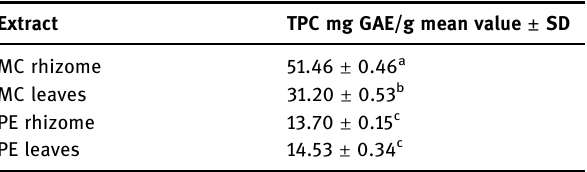
Table 1: Total polyphenolic contents in MC and PE extracts of rhizome and leaves of C. longa